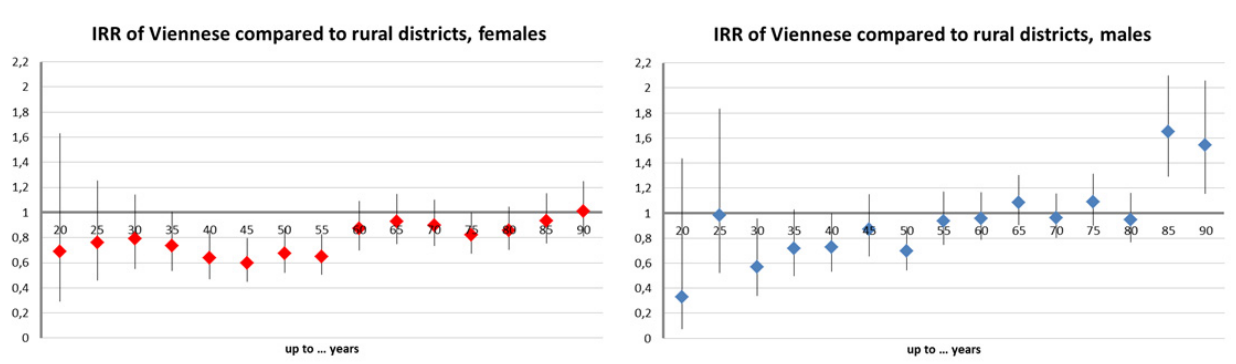
Figure 5. Age-group specific melanoma incidence risk ratios (IRR) and 95% confidence intervals (CI) in Viennese districts compared to rural districts: Raw incidence data controlled for altitude, year, and “Styrian” factors, and offset by the same year population number of the specific group; females (left), males